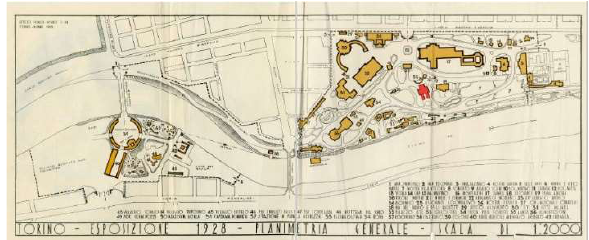
Figure 2. Planimetry “Exposition” held in Turin in 1928 – In red the “Mines and Ceramics” pavilion. In: Library